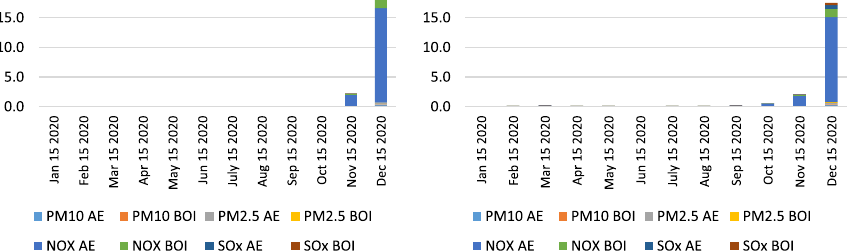
Fig. 12 Health‑related emission calculation of ships at anchorage area of the ports LA&LB based on energy and fuel‑based methodology (left) and Starcrest (right) excluding CO 2 in 2020 (in the average waiting time by months)